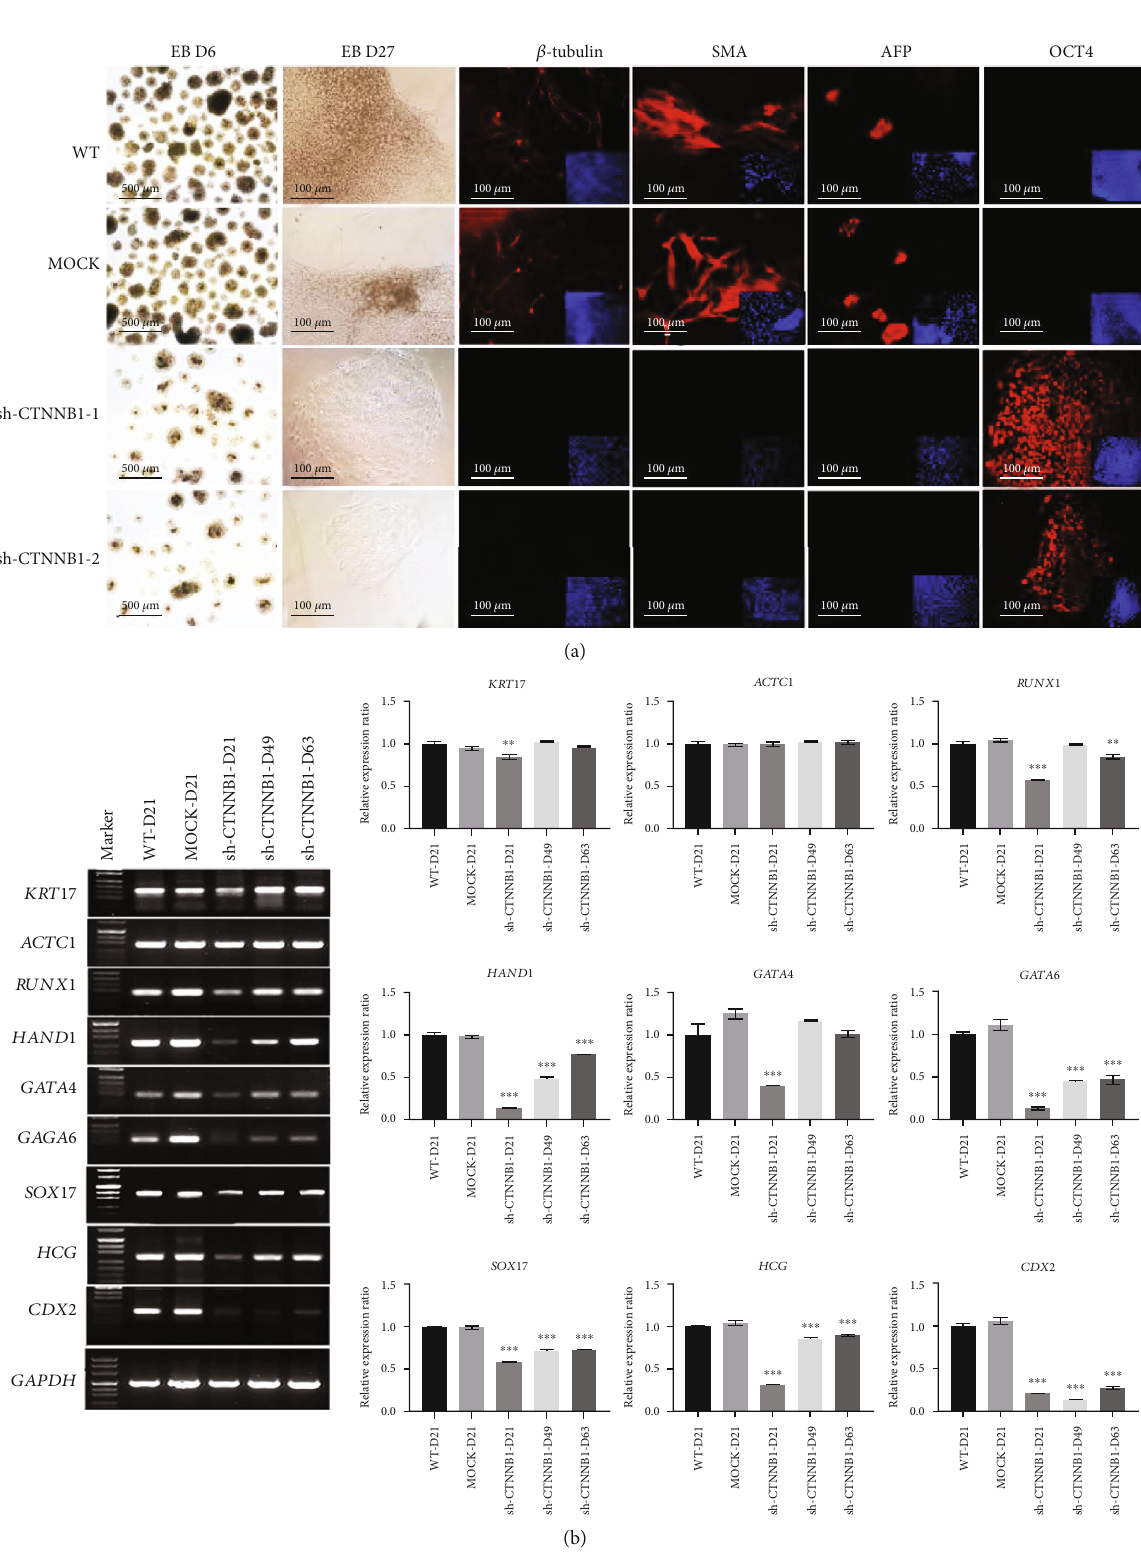
Figure 3: Suppression of multilineage di ff erentiation capability in shCTNNB1 hESCs. (a) Immuno fl uorescence staining shows β -tubulin, SMA, and AFP triploblastic markers in 21-42 days di ff erentiated hESCs ( scale bar = 100 − 500 μ m ). (b) Semiquantitative RT-PCR validation of mRNA expression levels of the three germ layers in 21-42 days di ff erentiated hESCs. The error bars denote mean ± SD from three independent experiments ( n = 3 , ∗ p < 0 : 05 , ∗∗ p < 0 : 01 , ∗∗∗ p < 0 : 001 , relative to WT